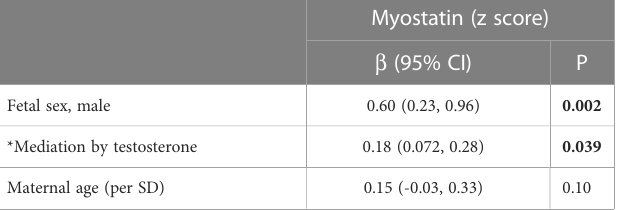
TABLE 6 Mediation analysis in the association of fetal sex with cord blood myostatin (n=110). correlation between cord blood myostatin and birth weight in 83 Myostatin (z